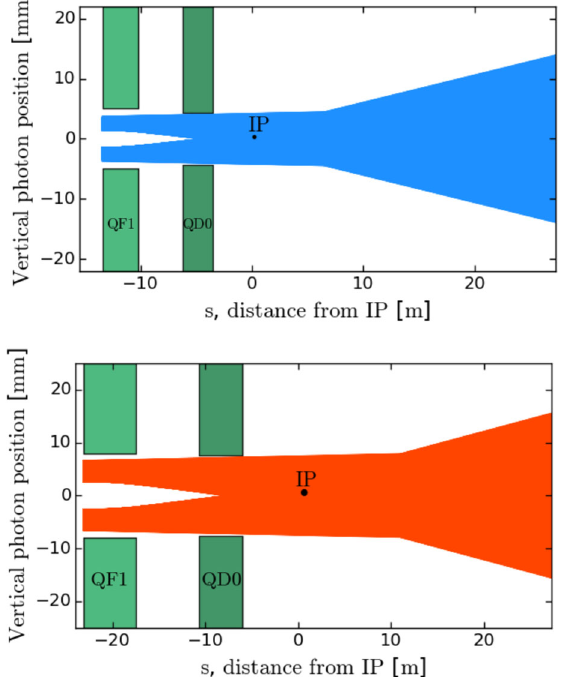
FIG. 15. Horizontal position of the emitted photons through the FD and CLIC detector, up to the entrance of the first postcollision magnet, for L (cid:1) ¼ 3 . 5 m (top plot) and L (cid:1) ¼ 6 m (bottom plot).